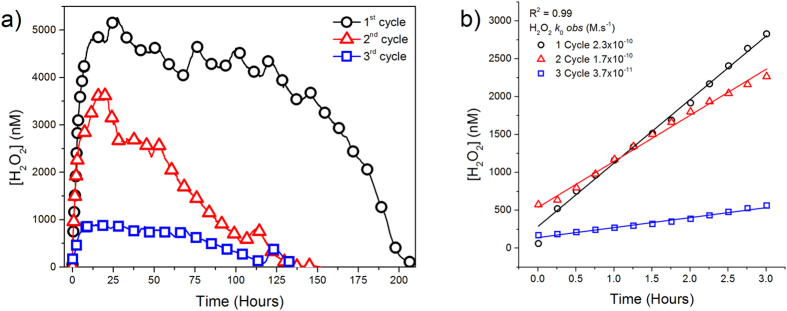
Recurrence of H2O2 formation by pyrite slurry after H2O renewal.(a) H2O2 evolution from the same pyrite slurry after renewing H2O twice, in oxic-open conditions (pyrite load particle = 0.33 g/L, ΔpH1cycle = 6.8–3.8, ΔpH2cycle = 6.8–6.1, ΔpH3cycle = 6.8–6.7); (b) Initial observed rate of H2O2 formation assuming a zero kinetic order rate.